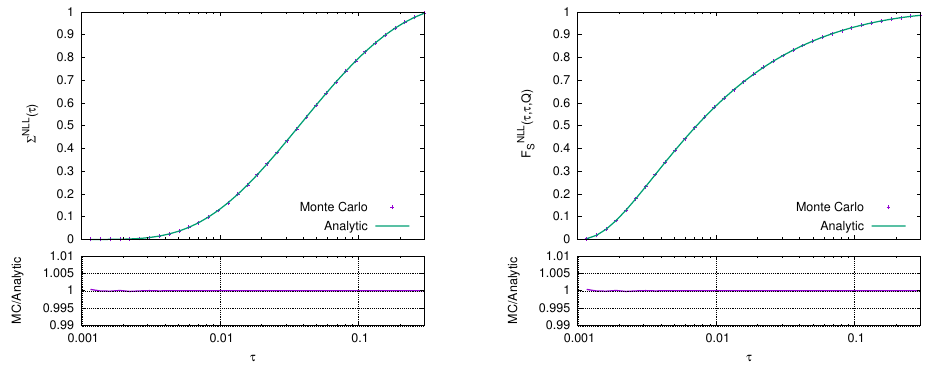
Figure 5 . The left (cid:12)gure shows the thrust cross section at NLL obtained with the Monte-Carlo algorithm given in the text (crosses in the plot). The analytic result is reported as a solid line for comparison. The right plot reports the comparison between numerical and analytical solutions for the soft transfer function at the same order. The numerical results have been obtained with ln( (cid:14) ) = (cid:0)